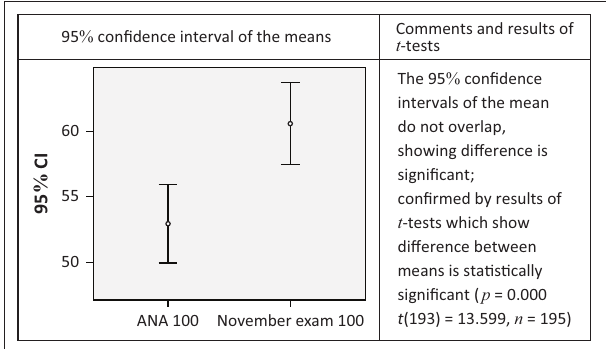
FIGURE 1: Confidence intervals of the means and results of t -test for in School A.